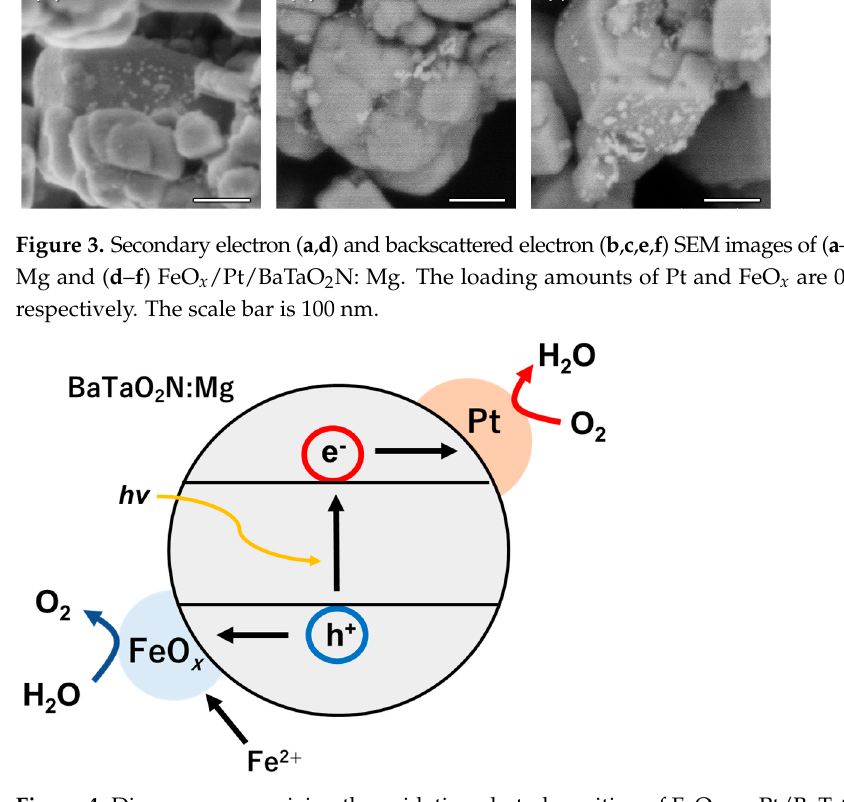
Figure 4. Diagram summarizing the oxidative photodeposition of FeO x on Pt/BaTaO 2